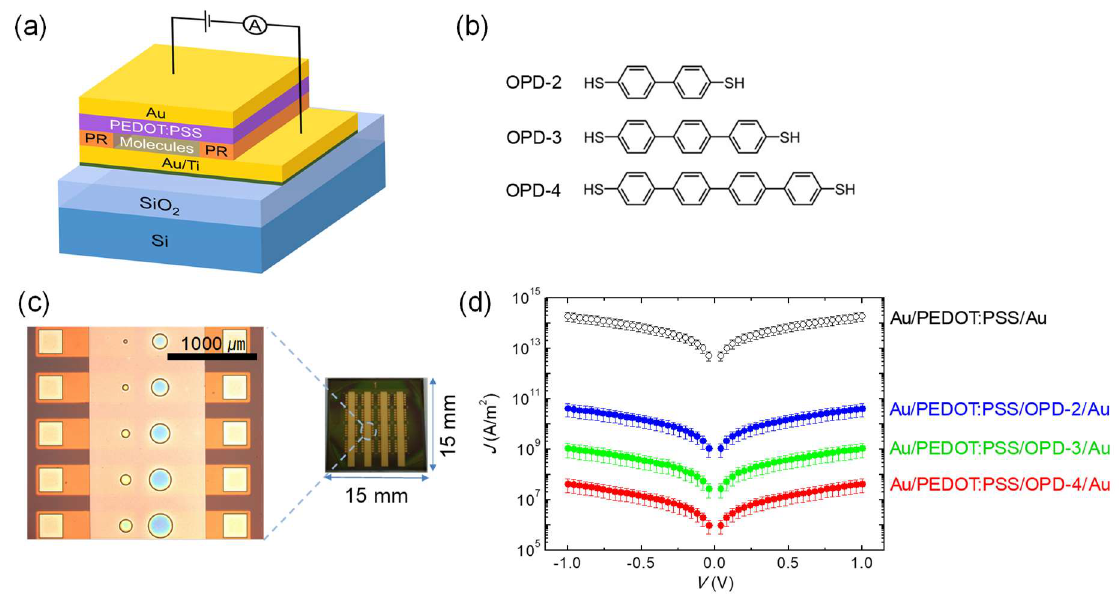
Figure 1. ( a ) Schematic image of PEDOT:PSS top-contact molecular ensemble junctions. ( b ) Chemical structure of oligophenylene dithiols with three different lengths ( n = 2, 3 and 4). ( c ) Optical images of fabricated devices, showing via-hole arrays with diameter 20–200 μm. ( d ) Room temperature J ( V ) curves of OPD-2, OPD-3, OPD-4, and PEDOT:PSS only junctions.